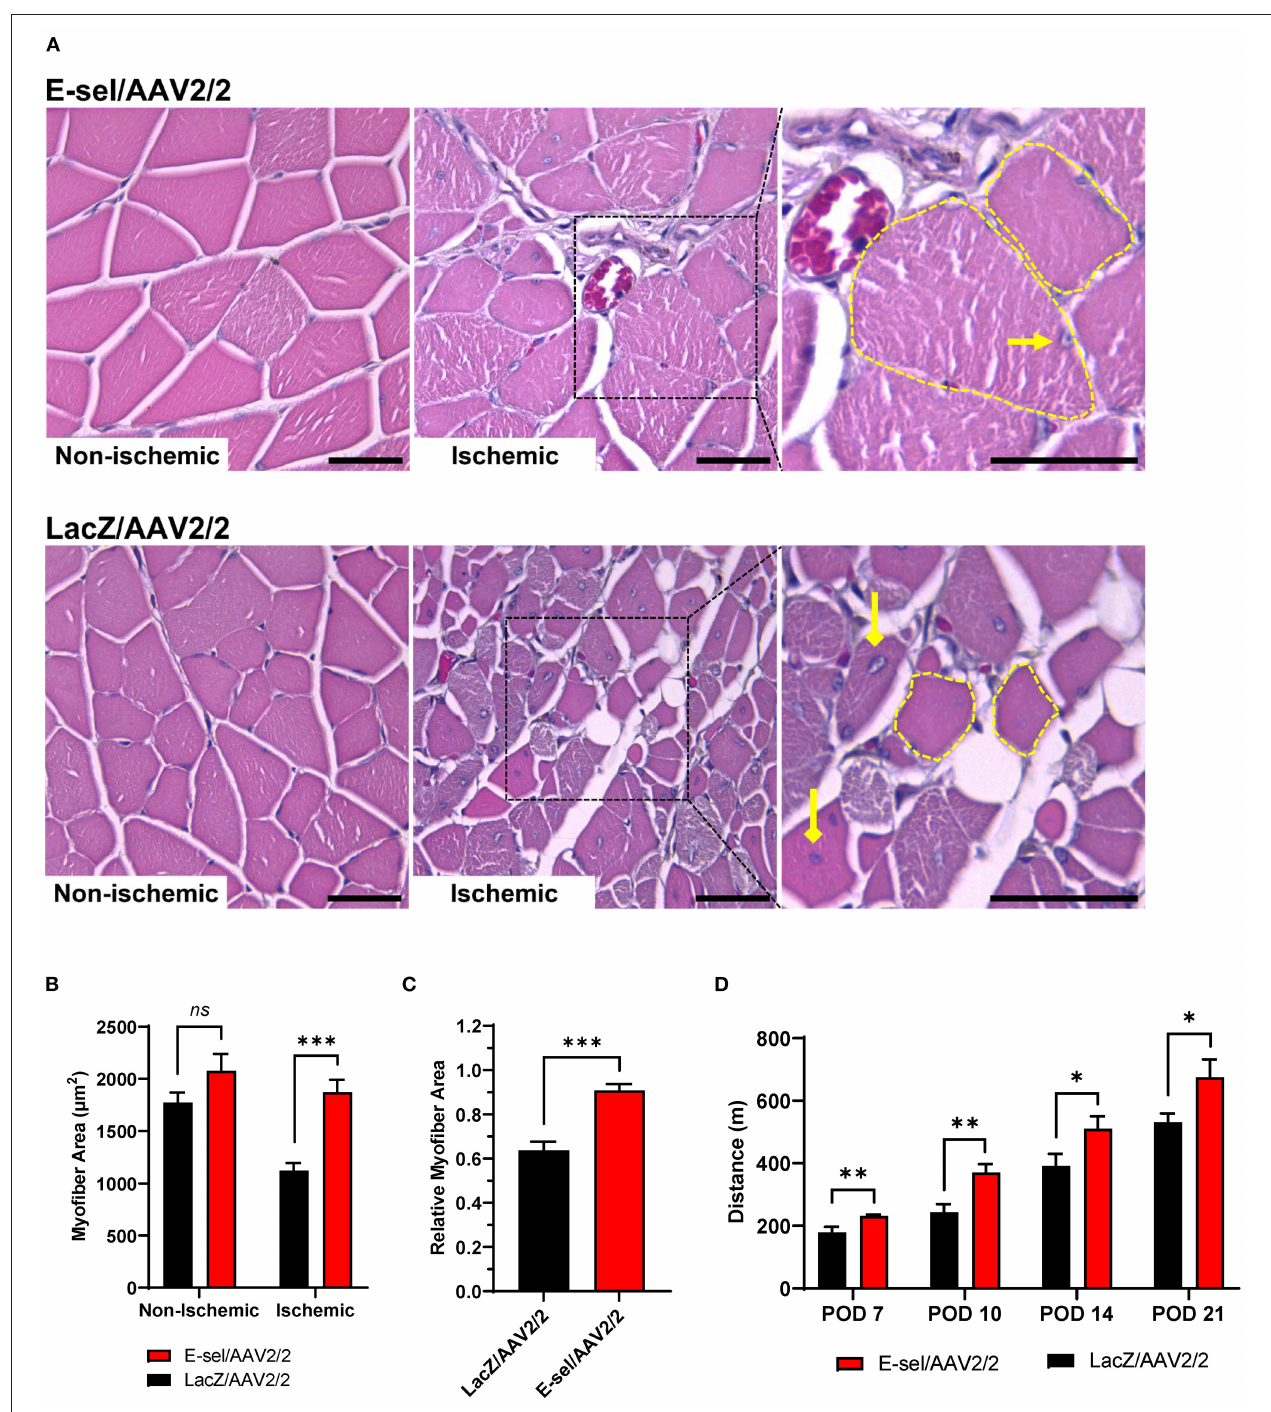
FIGURE 5 | E-sel/AAV2/2 gene therapy is associated with preserved myofiber integrity and improved functional recovery in ischemic hindlimb. (A) Representative H&E sections demonstrating better-preserved muscle integrity with larger myofiber size (dashed yellow line) and peripherally located nuclei (pointed arrowhead) in E-sel/AAV2/2-treated muscle compared to shrunken (dashed yellow line), eosinophilic necrotic fibers and centrally located nuclei (diamond arrowheads) observed in muscle treated with LacZ/AAV2/2. Scale bars represent 25 µ m. (B) Measurement of myofiber cross-sectional area demonstrating reduced myofiber size in LacZ/AAV2/2-treated compared to E-sel/AAV2/2-treated ischemic muscle. Non-ischemic myofiber size is comparable across groups. (C) Relative myofiber size in ischemic muscle compared to non-ischemic muscle is significantly larger after treatment with E-sel/AAV2/2 compared to LacZ/AAV2/2. (D) Mean distance walked on treadmill exhaustion testing at various timepoints postoperatively. Data are presented as mean ± SEM where * P < 0.05, ** P < 0.01, *** P < 0.001, and ns , not significant ( P > 0.05).